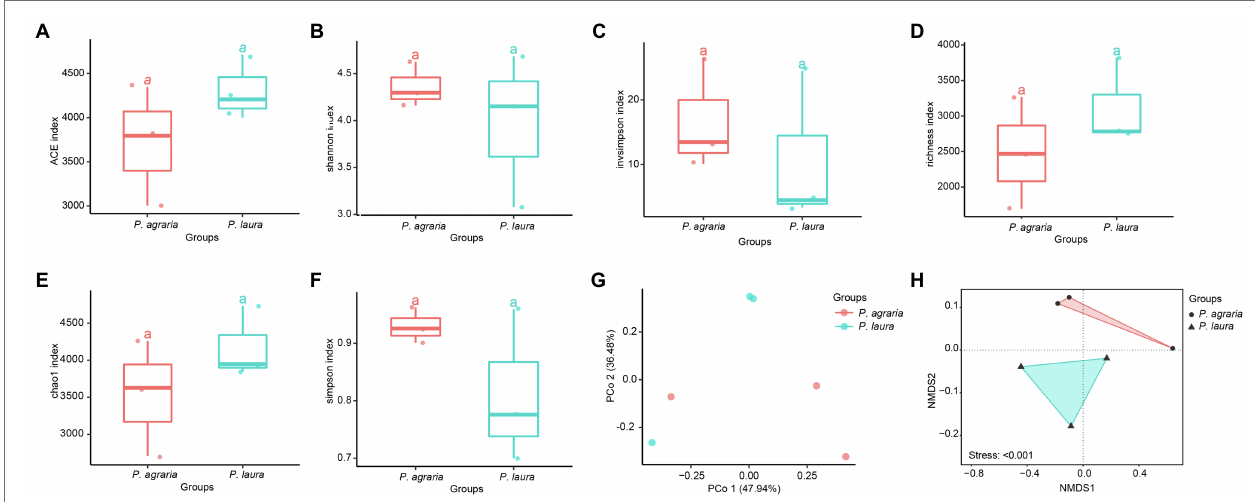
FIGURE 3 | Alpha-diversity at the species level of the gut microbial community between the two Pardosa species based on (A) ACE, (B) shannon, (C) invsimpson, (D) richness, (E) chao1 and (F) simpson metrices. Each point represents a sample, and three samples of each spider species were collected in 2018, 2019 and 2020. Significance between the spider groups is based on ANOVA/Tukey’s HSD test statistical methods. PCoA (Bray-Curtis metric) for visualization of gut microbial community dissimilarities. Samples colored by spider group (G) ( R 2 = 0.047; p = 0.9). The distance between two points represents their level of similarity. NMDS of occurrence-based Bray–Curtis dissimilarity of microbial species level communities from two Pardosa species (H)